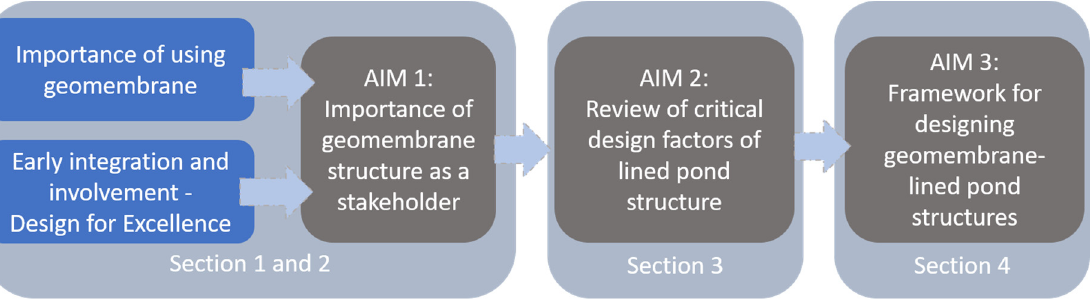
Figure 2. Flowchart of the work performed in this